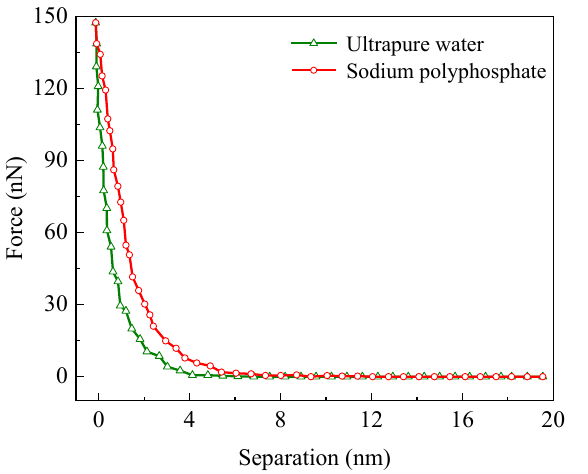
Figure 5. Interaction force test between hydrophilic particles in different solution environments.